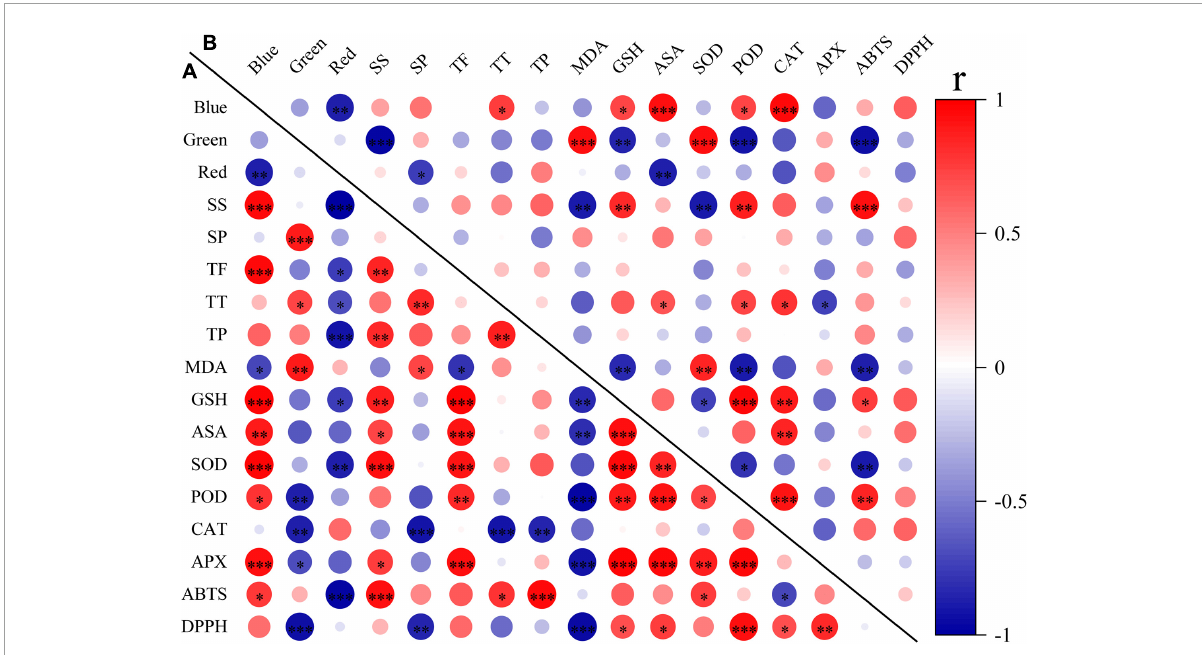
FIGURE9 The correlation among light spectral quality (blue, green, and red) and nutritional and antioxidant indicators in leaves (A) and in stems (B) . SS, soluble sugar content; SP, soluble protein content; TF, total flavonoids; TT, total triterpenes; TP, total polyphenols; MDA, malondialdehyde; GSH, glutathione; ASA, ascorbic acid; SOD, superoxide dismutase; POD, peroxidase; CAT, catalase; APX, ascorbate peroxidase; ABTS, 2,2 (cid:48) -azino-bis (3-ethylbenzthiazoline-6-sulfonic acid); DPPH, 2,2-diphenyl-1-picrylhydrazyl. Difference test at the ∗ P < 0.05, ∗∗ P < 0.01, and ∗∗∗ P < 0.001 level. The colors reflect the changes in correlation coefficient: red color represents correlation coefficient with high and positive correlation and blue indicates high and negative correlation.